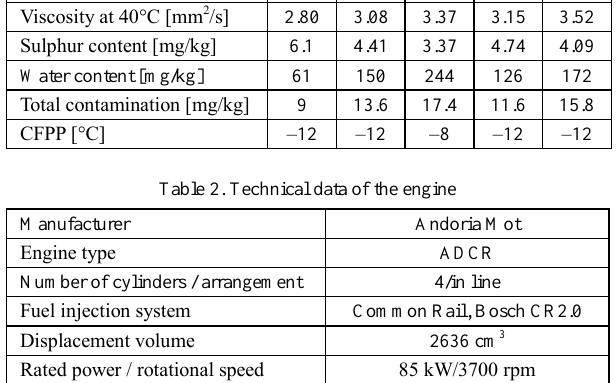
Fig. 1. Changes of BFCE in relation to DF for T25 and R25under different engine load conditions